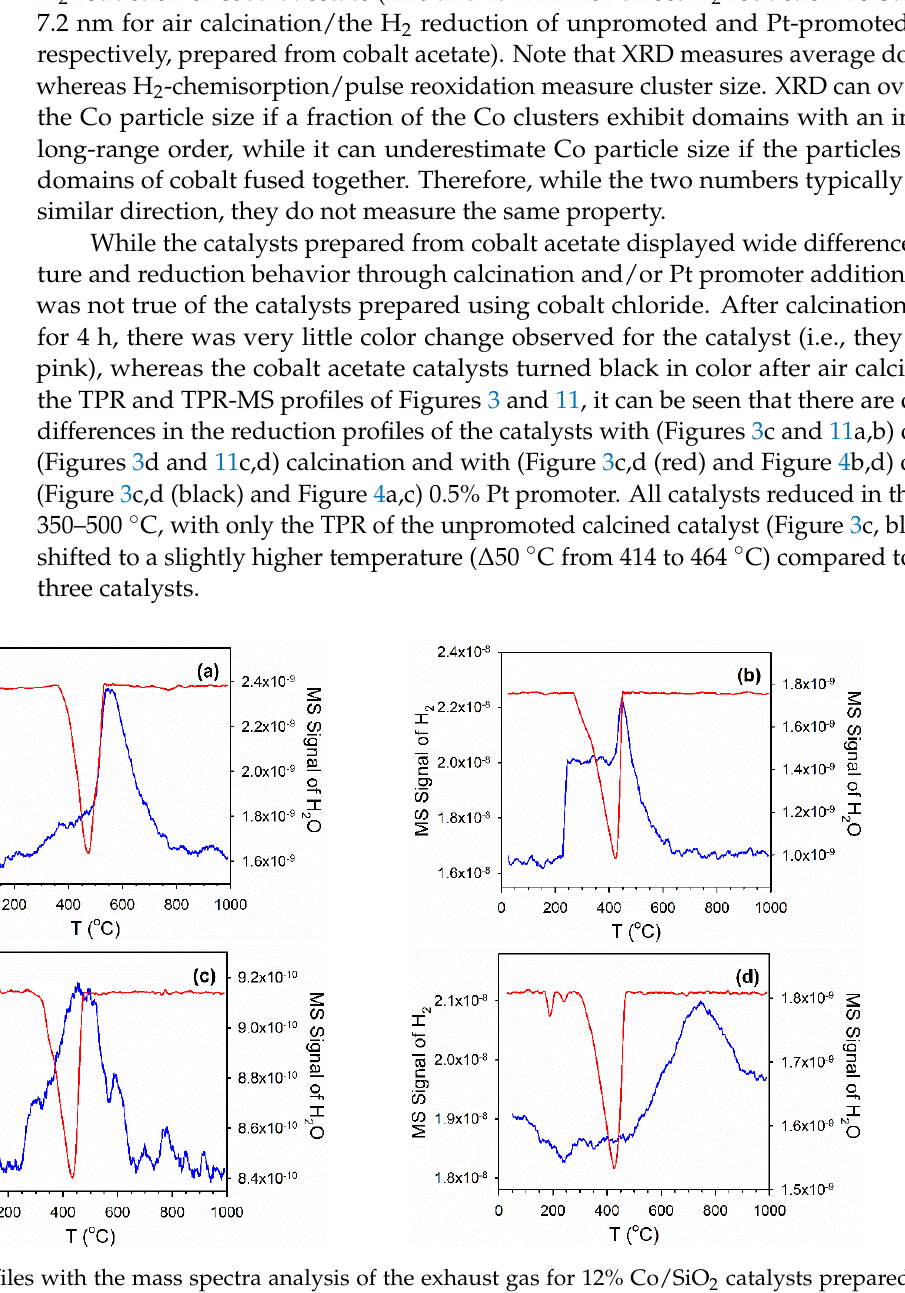
Figure 11. H 2 -TPR profiles with the mass spectra analysis of the exhaust gas for 12% Co/SiO 2 catalysts prepared with cobalt chloride, including ( a ) calcined, ( b ) calcined promoted with 0.5% Pt, ( c ) uncalcined, and ( d ) uncalcined promoted with 0.5% Pt. (Red) H 2 , (Blue) H 2 O.